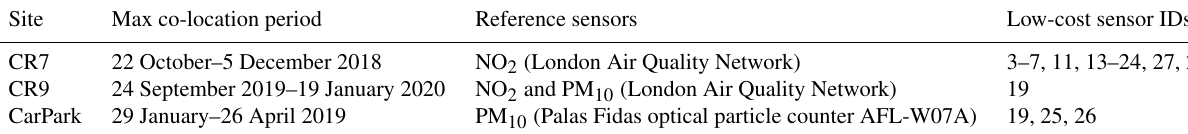
Table 1. Overview of the measurement sites and the corresponding maximum co-location periods, which vary for each specific sensor node and co-location site due to practical aspects such as sensor availability and random occurrences of sensor failures. Note that reference measurements for NO 2 and PM 10 are only available for two of the three sites each. Sensors that were co-located for at least 820 active measurement hours are identified by their sensor IDs in the last column. Further note that the only sensor used to measure at multiple sites is sensor 19, which is therefore used to test the feasibility of site transfers.